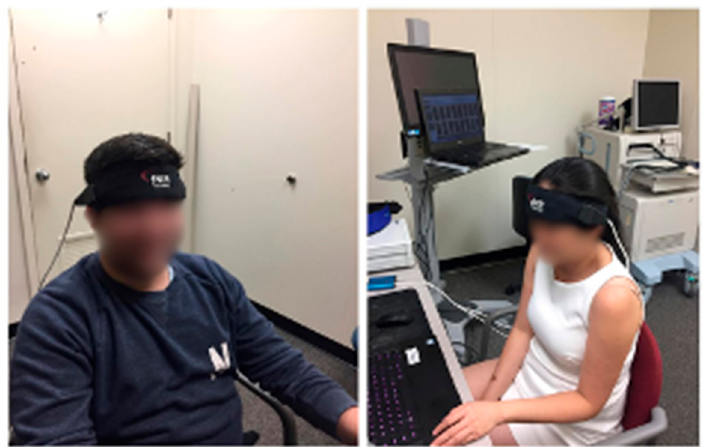
Figure 3. Participants wearing the fNIRS sensor pad.